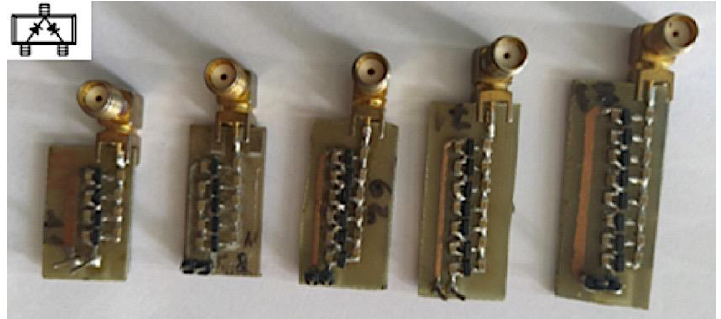
Figure 15. 4, 5, 6, 7, and 8 stage multipliers.